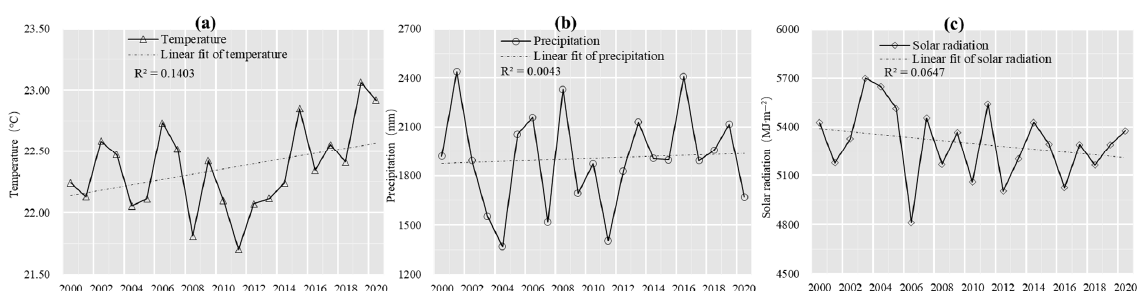
Figure A1. Temporal variability of ( a ) temperature, ( b ) precipitation, and ( c ) total solar radiation data in the GBA from 2000 to